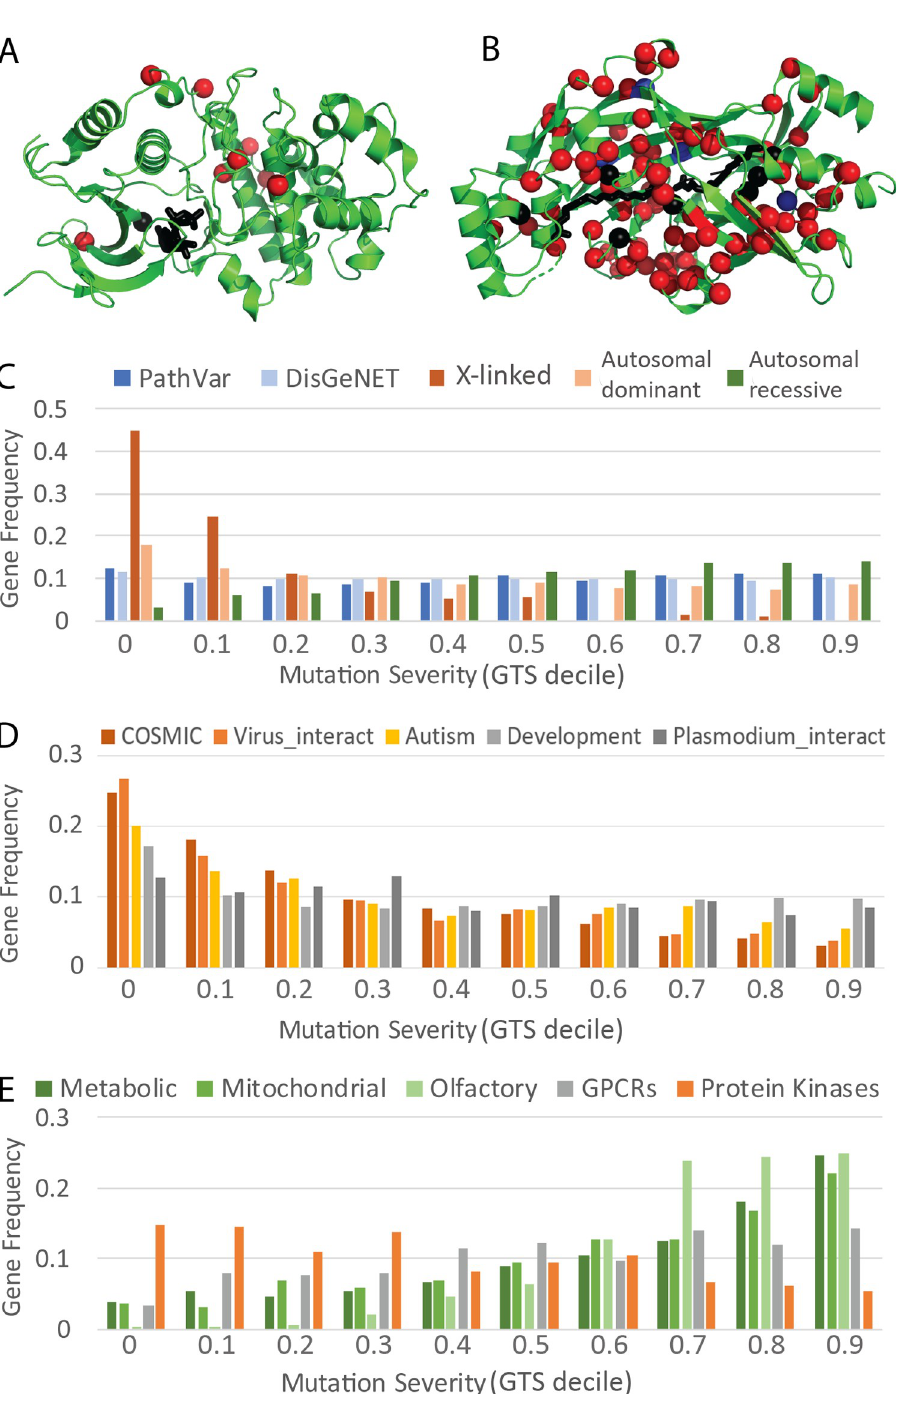
Fig 5. Mutation-intolerant and mutation-tolerant genes prefer different pathways and disease types. A) Top ranked genes with low GTS scores like ERK2 kinase (PDB 4fmq) have relatively few DeepSAV predicted deleterious variant positions (DeepSAV score > 0.75, red spheres). One of these (black sphere) is near ( < 4 Å ) the active site (ANP substrate analog in black stick). B) Bottom ranked genes with high GTS scores like CD36 (PDB 5lgd) are tolerant to predicted deleterious mutations (DeepSAV score > 0.75, red spheres), including several positions (black spheres) lining the fatty acid (black stick) binding sites or with known pathogenic variation in platelet glycoprotein deficiency (blue spheres). C) Mutation severity spectrum of disease-associated genes in general, measured by their frequencies in GTS deciles. (PathVar–genes with pathogenic SAVs in ClinVar and UniProt, DisGeNET–genes with diseases in DisGeNET database, X-linked, Autosomal dominant, and Autosomal recessive correspond to sets of genes